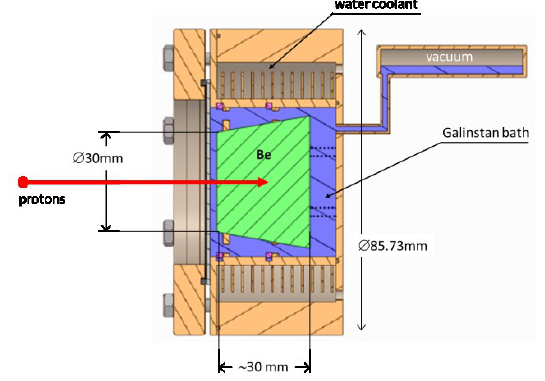
Fig. 5. Conceptual representation of the CoolGAL target system. The proton beam comes from the left, crosses a havar 25 micron thick window (visible in Fig.6) and a 1 mm thick liquid layer before it is stopped by the thick Be component (yellow). The Be is immersed in a Galinstan bath (purple) contained by a copper cladding.